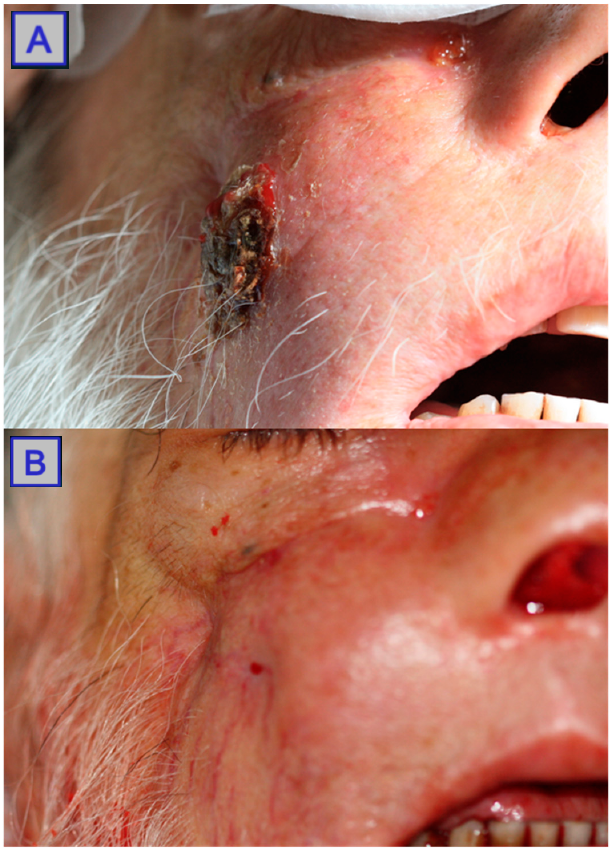
Figure 9. Images of a fungating tumour mass. Interstitial PDT was carried out on the mass ( A ). Post-PDT ( B ) shows a reduction in tumour size with no ulceration and extensive skin regeneration. Reprinted with permission from ref. [43]. Copyright 2010 Photodiagnosis Photodyn. Ther. Table 1. Summary of recent clinical trials investigating the use of Photodynamic therapy(PDT) in nasopharyngeal carcinoma (NPC). * Only 17/22 patients had treatment response evaluated.